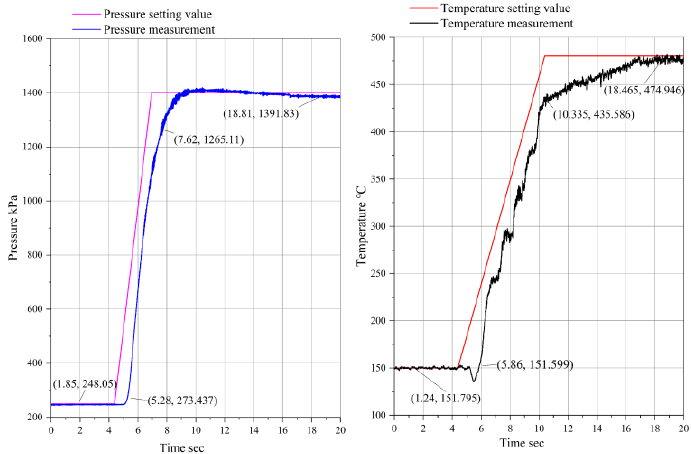
Figure 9. Compressor bleed air simulation of test piece one under the rise rates of 480 kPa/s and 55 °C/s.